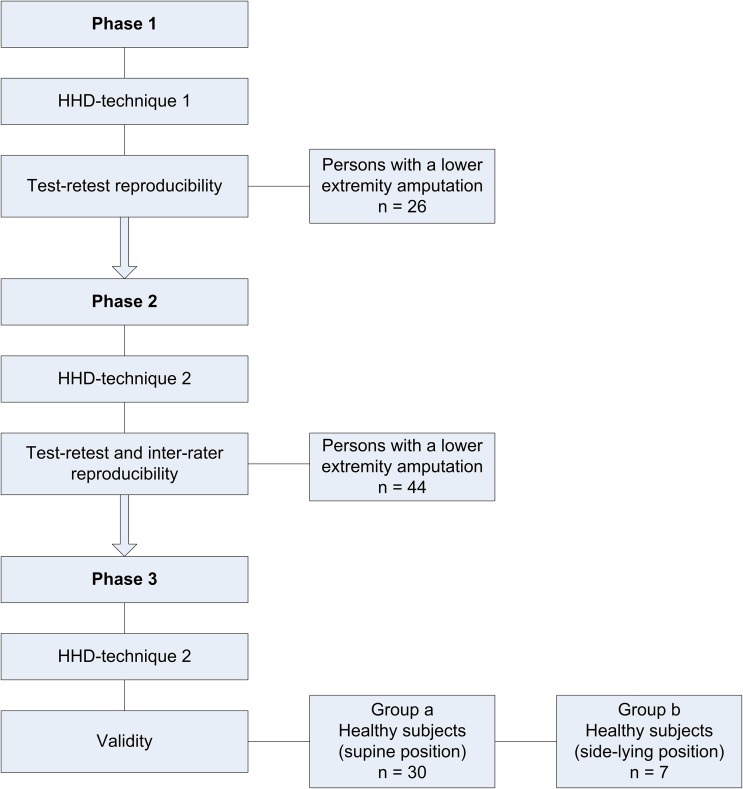
Flowchart study.